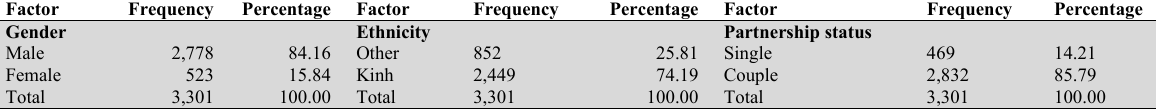
Description of research sample based on gender, ethnicity and partnership Factor Frequency